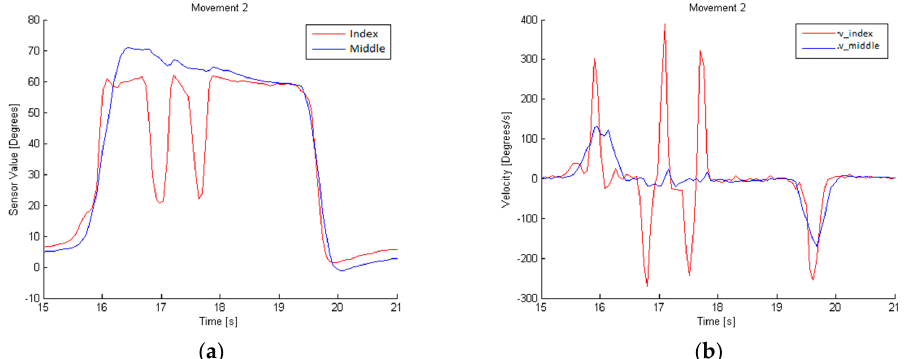
Figure 8. ( a ) Glove sensor data, which are proportional to the flexion of the finger in movement 2; ( b ) Velocity of the flexion involved in movement 2.